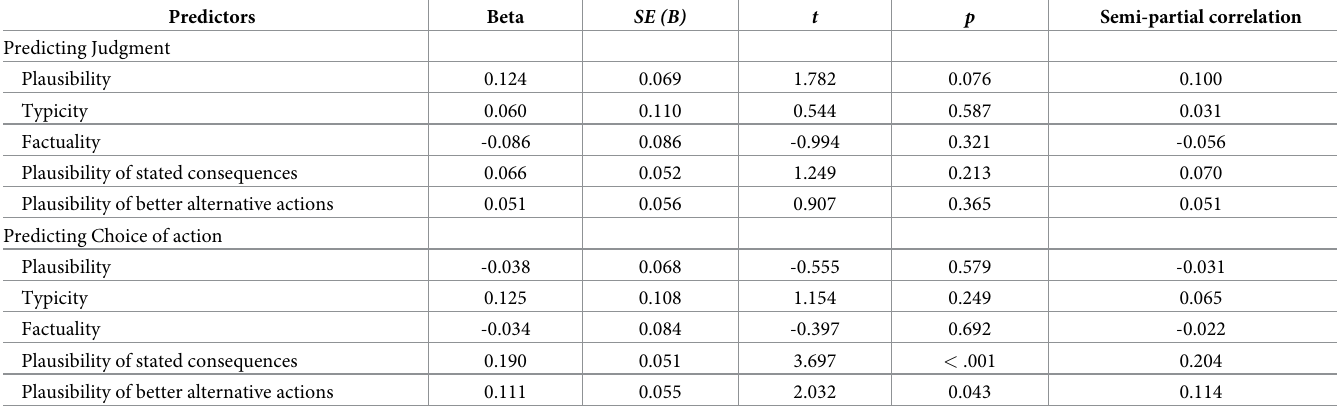
Table 5. Results of linear regression analyses predicting moral choice ratings from ratings of perceived realism and plausibility of